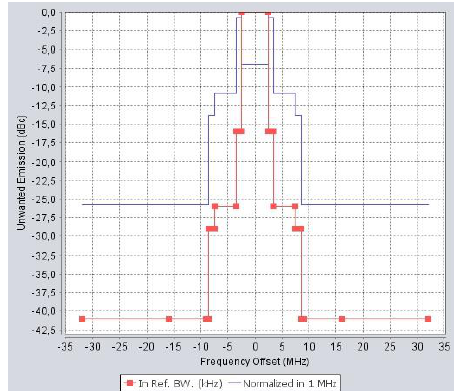
Fig. 11. LTE UE emission mask based on ETSI TS 136 101 V10.6.0.